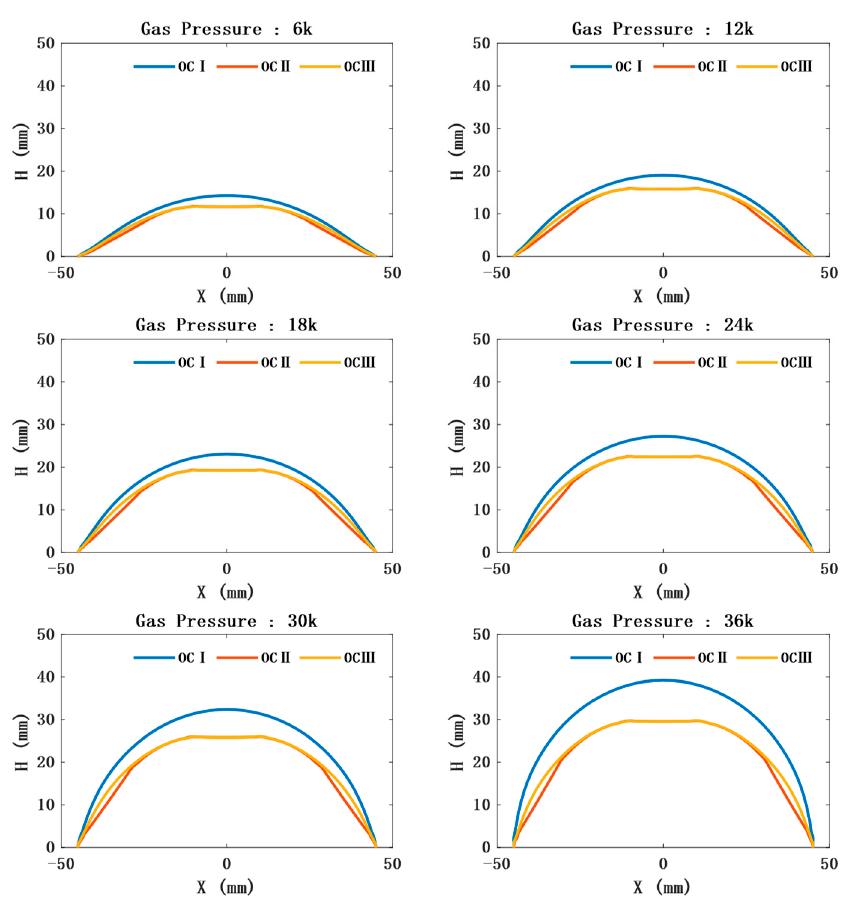
Figure 7. Outline drawing under different air pressures. OCI represents the outline of CTPM under different air pressures; OCII represents the contour of the line where SAM is constrained the most, that is, it is constrained by three sensors and passing through the central axis; OCIII represents the contour of the line whose SAM is constrained the least, that is, it is constrained by only one sensor in the center and passing through the central axis.